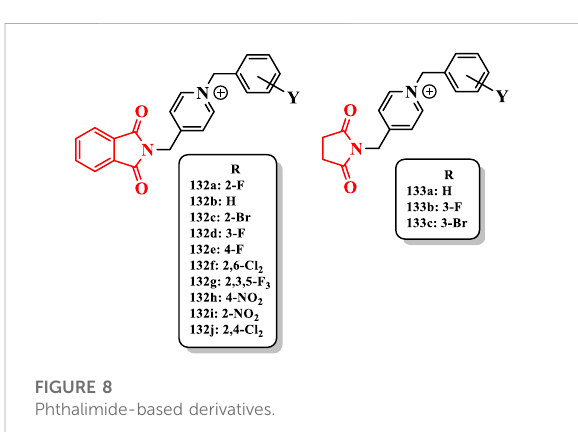
FIGURE 8 Phthalimide-based